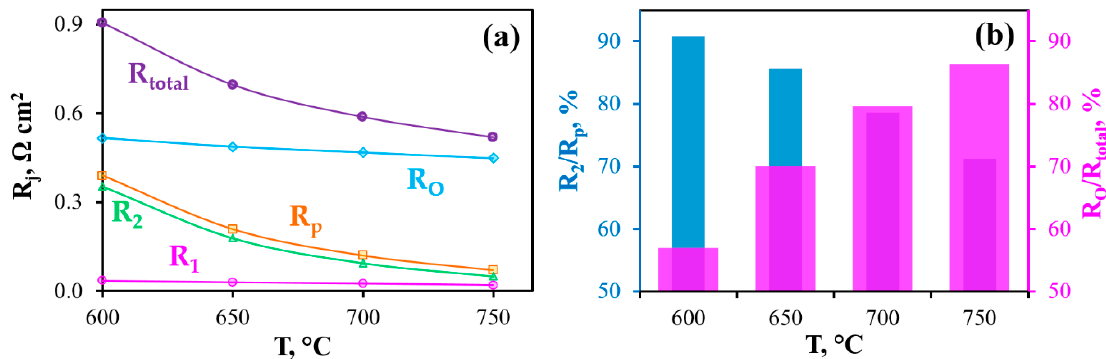
Figure 6. ( a ) Constituent resistances (R j ) of the total resistance of the PCC depending on temperature; ( b ) Contributions of Process II in the total polarization resistance and the ohmic resistance in the total resistance of the PCC at different temperatures.